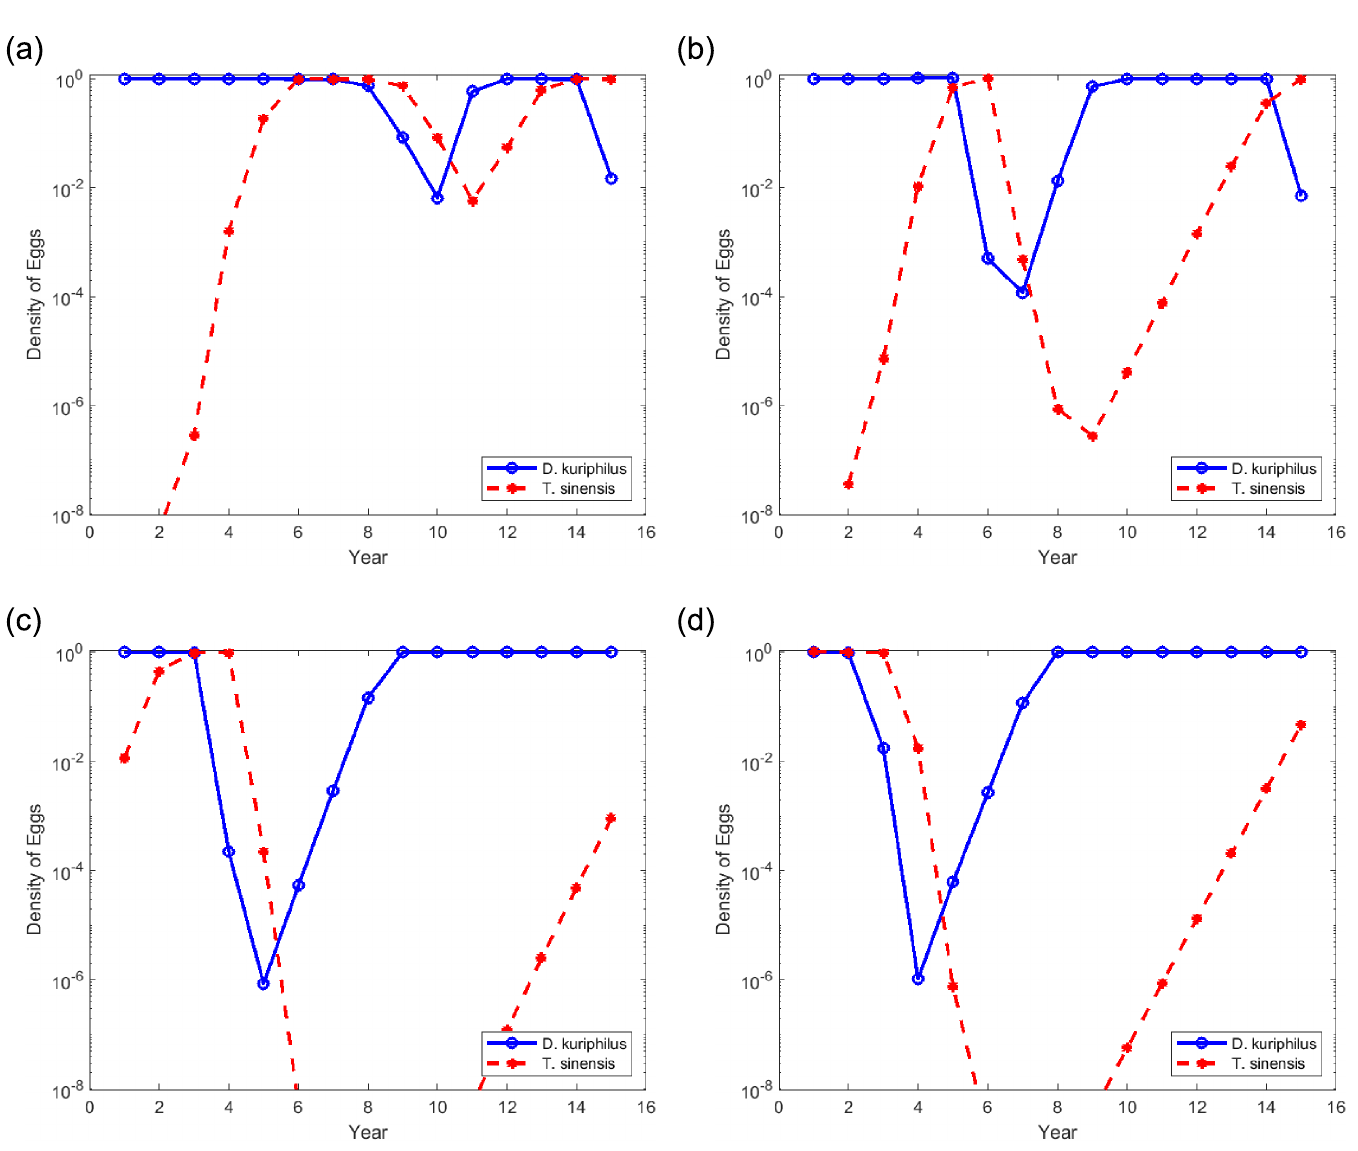
Fig 7. Egg density of D. kuriphilus ( v n ) and T. sinensis ( q n ) at a fixed position in the computational domain as a function of time, after multiple simultaneous releases of T. sinensis performed at year 0 from stations placed on a regular